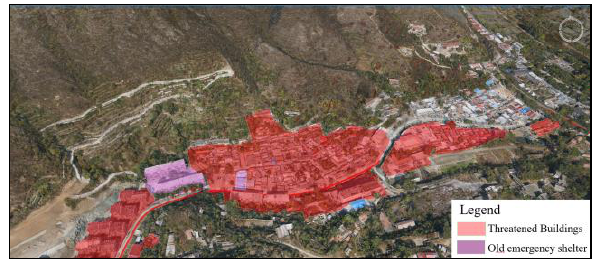
Figure 11 . Location relationship of debris flow deposits, threatened buildings and emergency shelter.